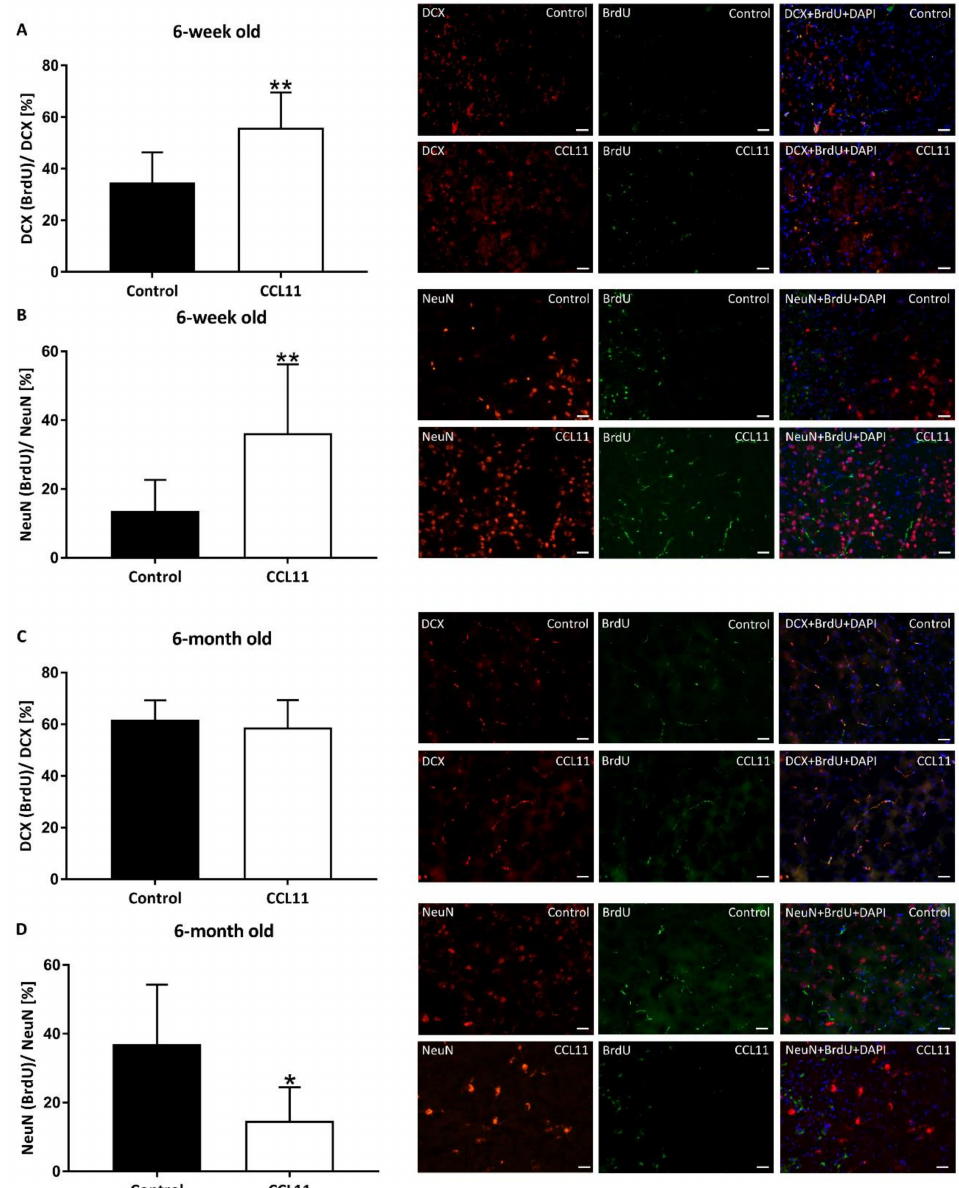
Figure 4. CCL11 di ff erentially regulates post-stroke neurogenesis in adolescent and adult mice. C57BL6 male mice were subjected to cerebral ischemia for 45 min followed by reperfusion for 28 d. At the beginning of the reperfusion, mice received intraperitoneal injections of either 10 µ g / kg bodyweight of CCL11 or 100 µ L of PBS as control followed by daily injections on the seven consecutive days after reperfusion. From day 8 to day 18, BrdU was intraperitoneally injected in mice. Neurogenesis was evaluated by co-expression analysis of the neuronal markers together with the proliferation marker BrdU in 5 ROIs of both adolescent ( A , B ) and adult ( C , D ) mice. In (A) DCX and BrdU co-localized cells, **significantly di ff erent from the corresponding control, p = 0.006, in ( B ) NeuN and BrdU co-localized cells, **significantly di ff erent from the corresponding control, p = 0.008, in ( C ) DCX and BrdU co-localized cells, ns p = 0.445, in ( D ) NeuN and BrdU co-localized cells, *significantly di ff erent from the corresponding control, p < 0.030. Photographs depicted beside each diagram show representative stainings for each experimental condition. n = 8 in the CCL11 group and n = 10 in the control group of adolescent mice. n = 6 in the CCL11 group and n = 7 in the control group of adult mice. All data are given as means ± S.D., scale bars 20 µ